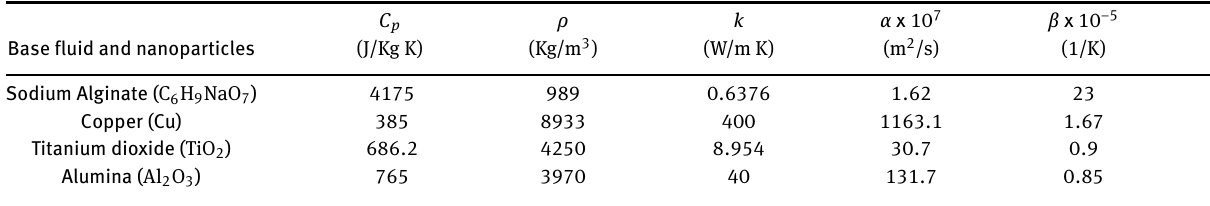
Table 1: Thermophysical properties of base fluid and nanoparticles